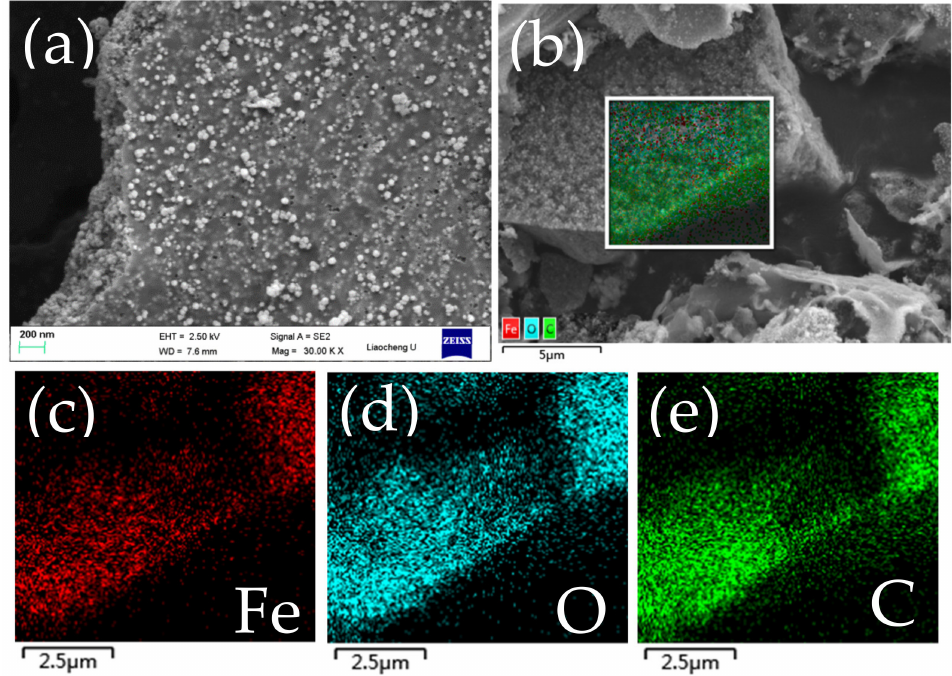
Figure 3. Fe 2 O 3 @C composite: ( a ) SEM image, ( b ) EDS hierarchical image, ( c – e ) EDS spectrum with elemental